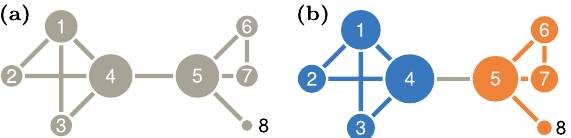
Fig. 3 Illustration of the centrality scores from Table 1. Node colours indicate community assignments, node diameter is proportional to a degree centrality and PageRank without teleportation, and b map equation centrality